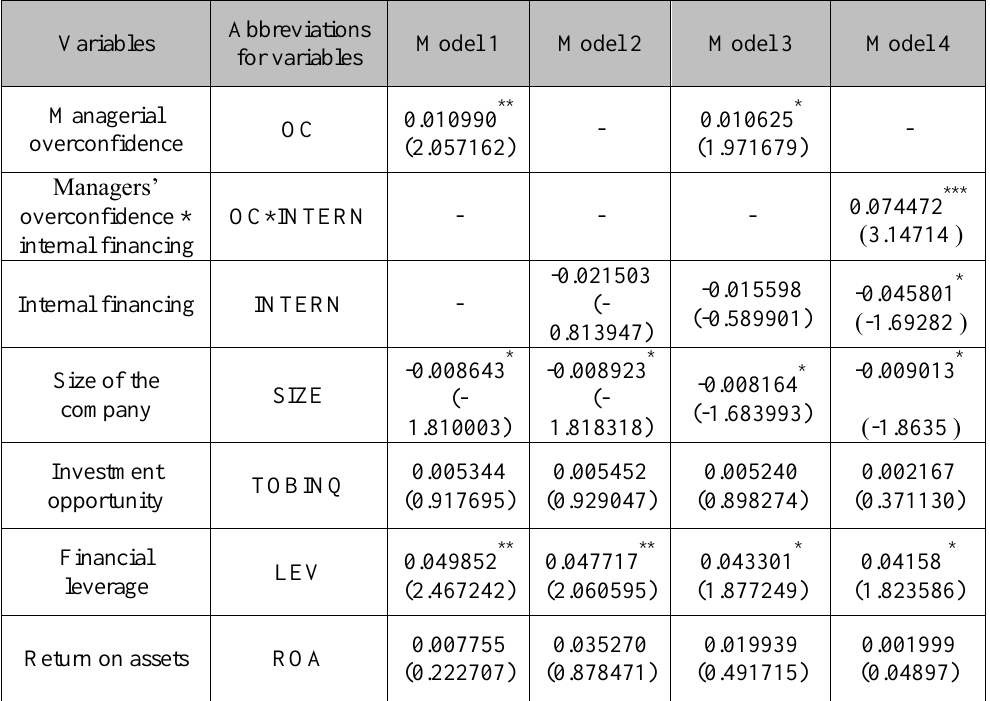
Table 10. Results of typical regression test - Dependent variable of